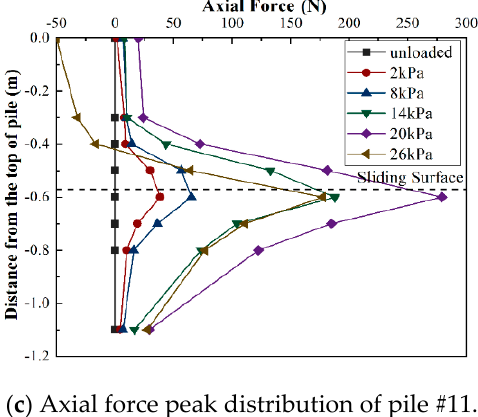
Figure 16 . Axial force distribution for each row of piles (static model test). Figure 16. Axial force distribution for each row of piles (static model